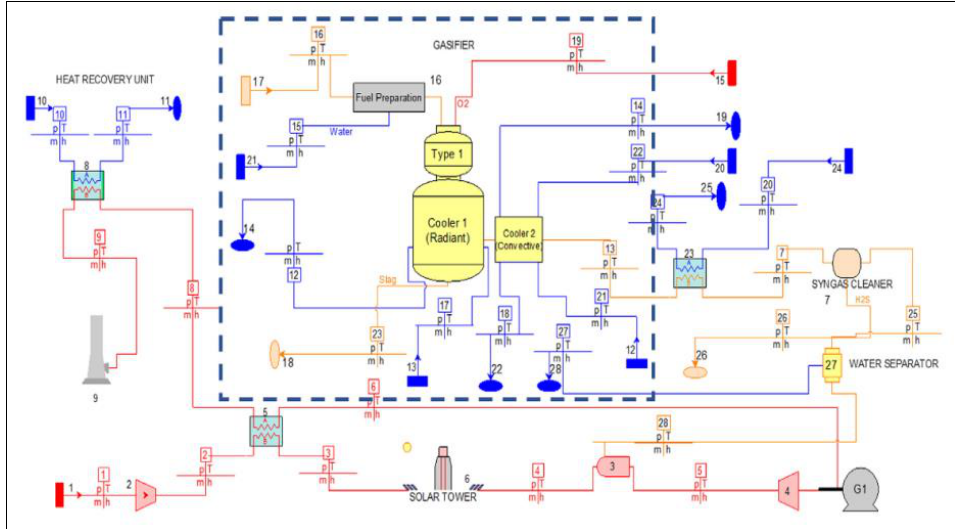
Figure 7. Hybrid MGT-solar power plant with olive pits gasifier [88].